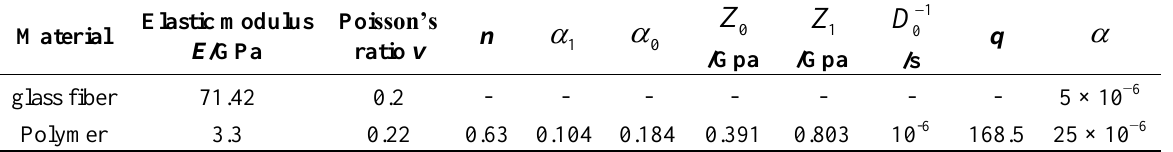
Table 2. Material parameters of the glass fiber and polymer matrix.